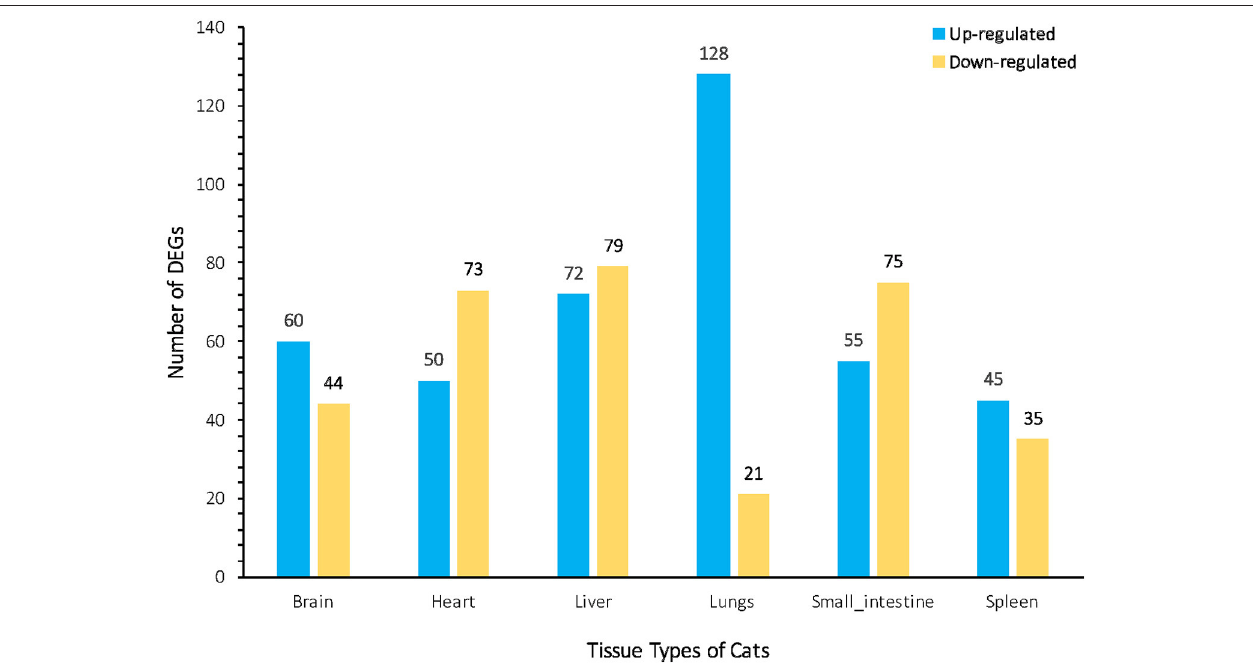
FIGURE 1 | Bar plot representation of the differentially Expressed Genes (DEGs) across the cat tissues after acute T. gondii infection. The numbers of up-regulated and down-regulated DEGs assigned to each cat tissue are indicated above the bars. The greatest changes in DEGs between infected and uninfected tissues were observed in the liver and lung.